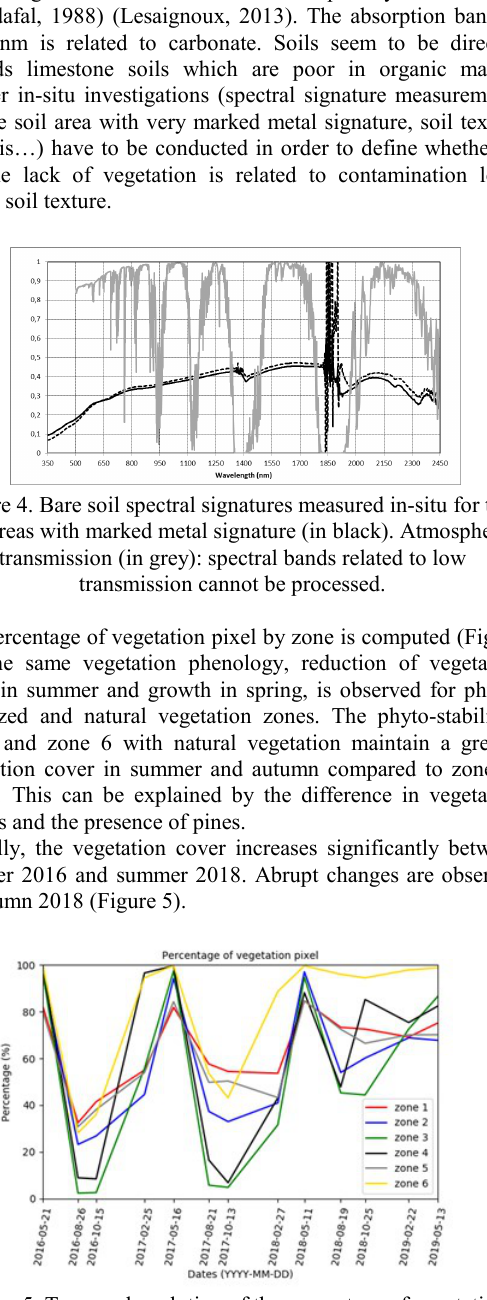
Figure 5. Temporal evolution of the percentage of vegetation cover pixel by zone between 2016 and 2019.